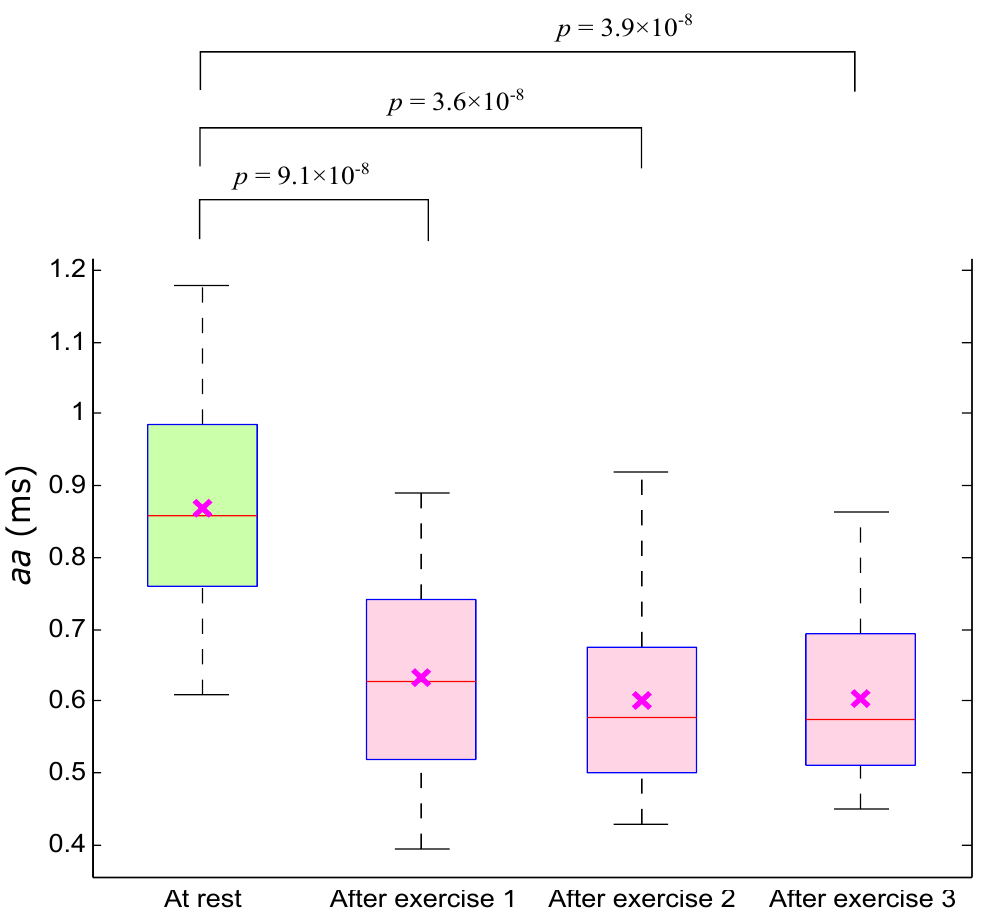
Figure 5. Boxplot of the aa interval for subjects measured before and after exercise. The p -value was calculated using the paired Mann–Whitney